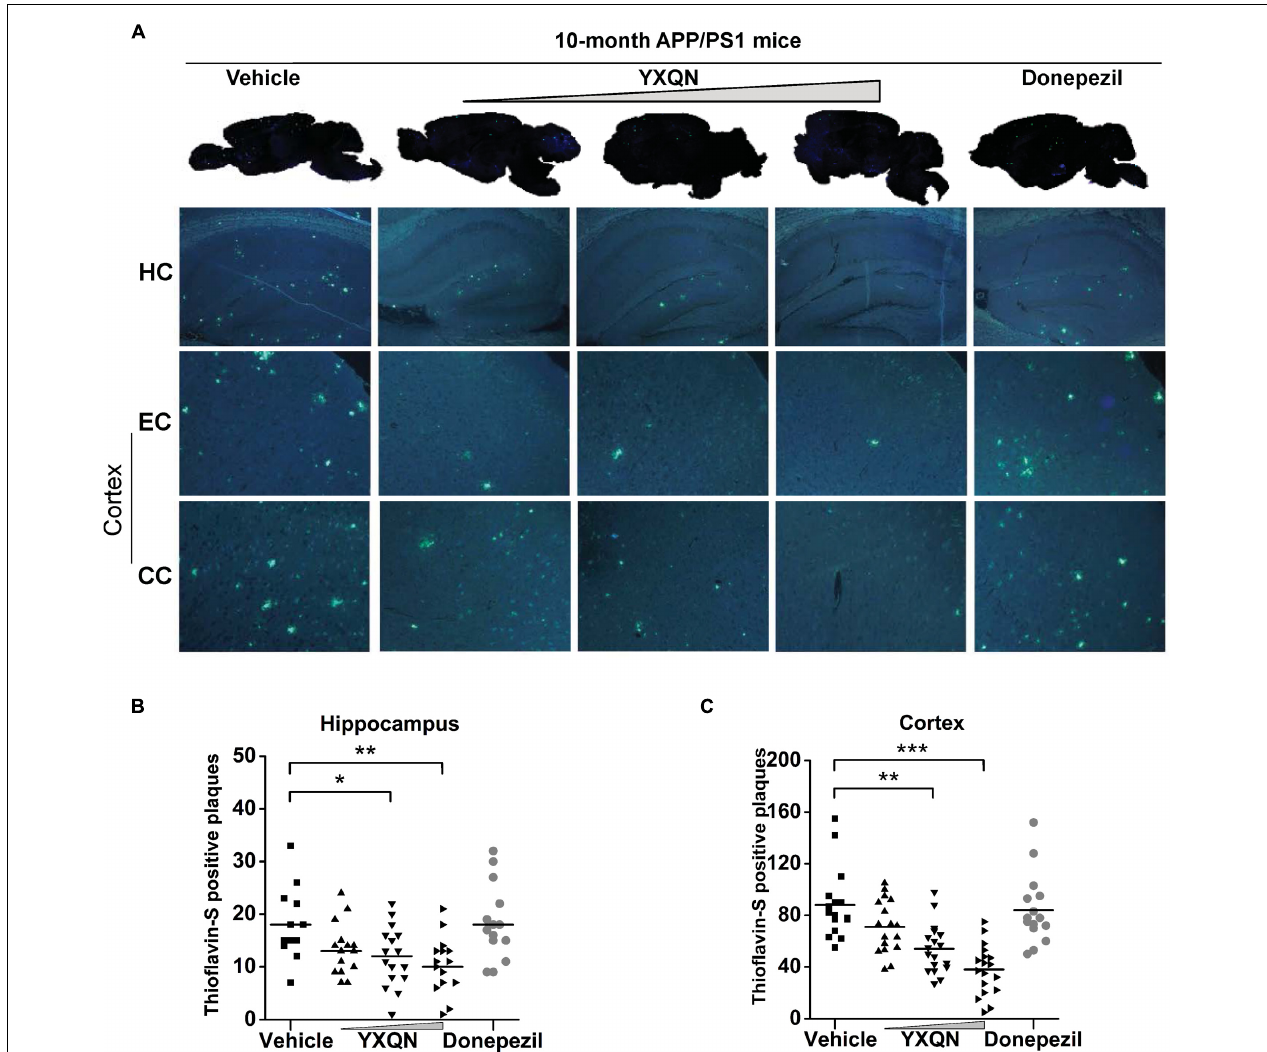
FIGURE 5 | Yangxue Qingnao decreases A β deposition that presents both in hippocampus and cortex of APP/PS1 mice. (A) In the APP/PS1 mice with vehicle, YXQN, and donepezil supplementation, A β deposition was quantified in whole-brain sagittal plane and hippocampus (HC), entorhinal cortex (EC) or cingulate cortex (CC) area using thioflavin S. (B,C) Quantitative analysis of the number of A β plaques loaded in cortex region (B) and hippocampus region ( C ; n = 12–18). The drug dosages from low to high of YXQN extract are 0.69, 2.08, and 6.24 g/kg. Mean ± S.E.M. ANOVA with Dunnet’s post hoc analysis was used. ∗ p < 0.05, ∗∗ p < 0.01, and ∗∗∗ p <